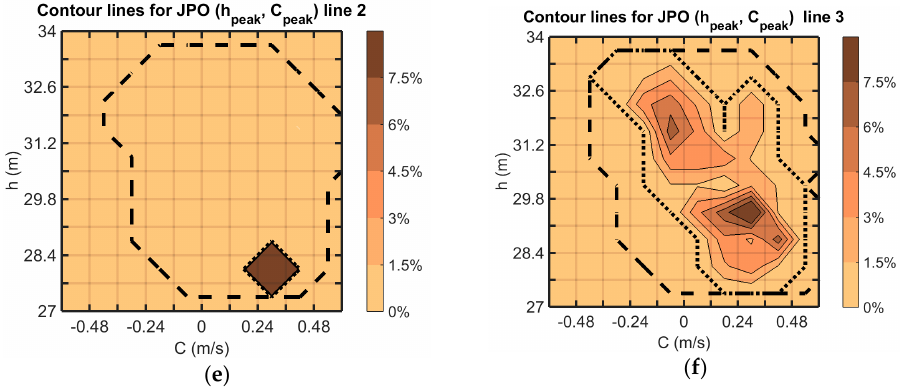
Figure 11. JPO for SWMTF environmental conditions associated with peak mooring loads: JPO ( H S peak , T P peak ) on mooring lines ( a ) 1, ( b ) 2 and ( c ) 3; JPO ( h peak , C peak ) on mooring lines ( d ) 1, ( e ) 2 and ( f ) 3. The large black dashed line is the external contour line of the general environmental conditions. The thin black dotted line is the external contour line of the environmental conditions associated with peak mooring load.